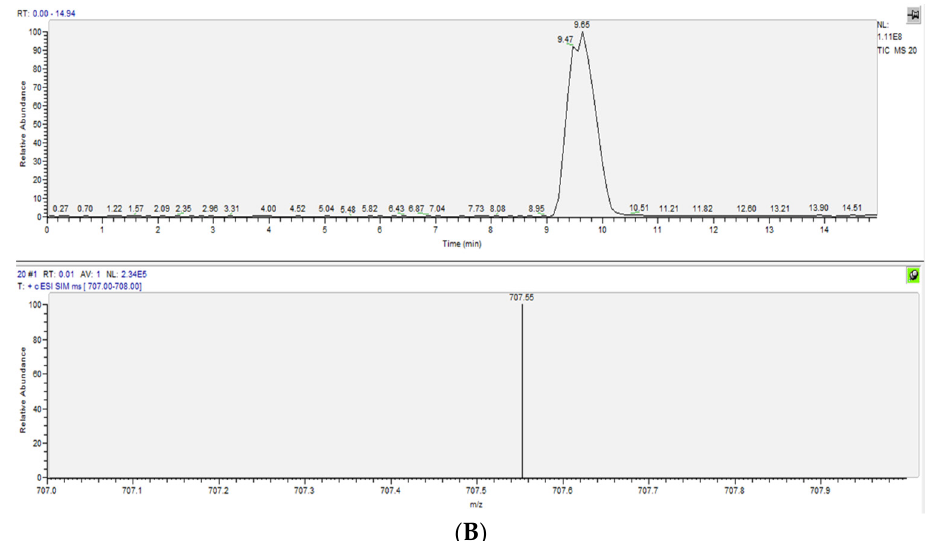
Figure 6. ( A ) Structure and ( B ) EIC and ESI/MS spectrum of the phospholipid standard 1,2-Di-O- hexadecyl-sn-glycero-3-phosphocholine, PC(O-16:0/O-16:0). For HPLC, the stationary phase selected was a C 8 column, and the mobile phase selected was 70% acetonitrile, 30% isopropanol, and 0.1% formic acid. The ESI/MS conditions were as in Figure 4.